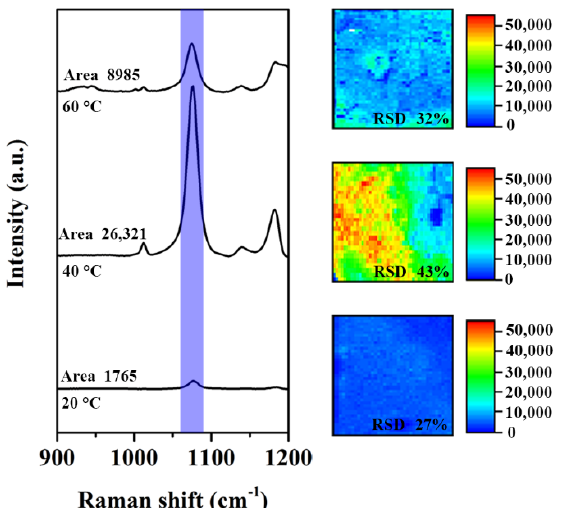
Figure 9. SERS efficiency evaluation and false colour intensity maps for the samples synthetized using 10 mM AgNO 3 combined with a 3-mL/min flow rate, at different temperatures. The SERS spectra in this figure are the average of all the spectra collected by the mapping.